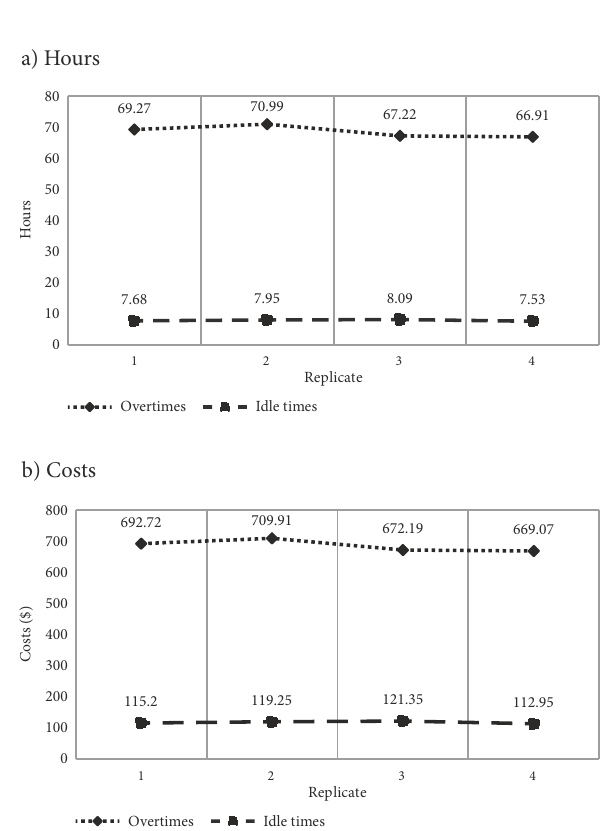
Figure 15. The comparison of overtime and idle time between